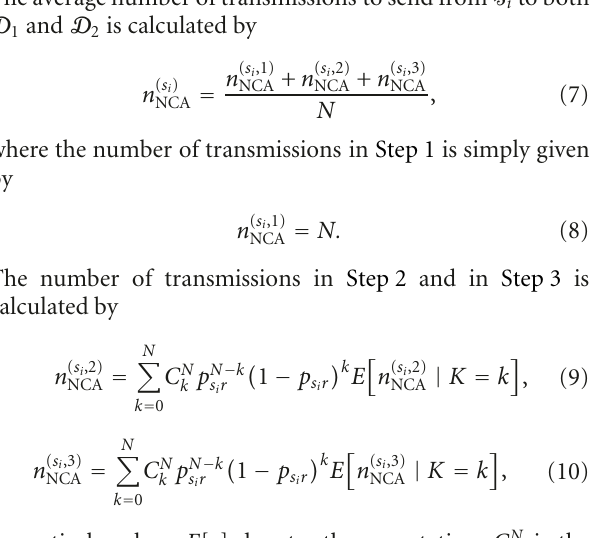
Algorithm 2: Algorithm at source to retransmit Type-II